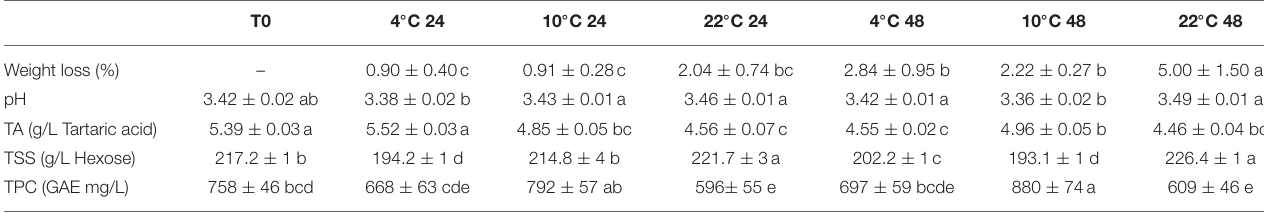
TABLE 1 | Technological parameters in grapes ( Vitis vinifera L. cv Vermentino) at harvest (T0) and after the following postharvest cooling treatments: 4 and 10 ◦ C for 24h (4 ◦ C 24 and 10 ◦ C 24) and 48h (4 ◦ C 48 and 10 ◦ C